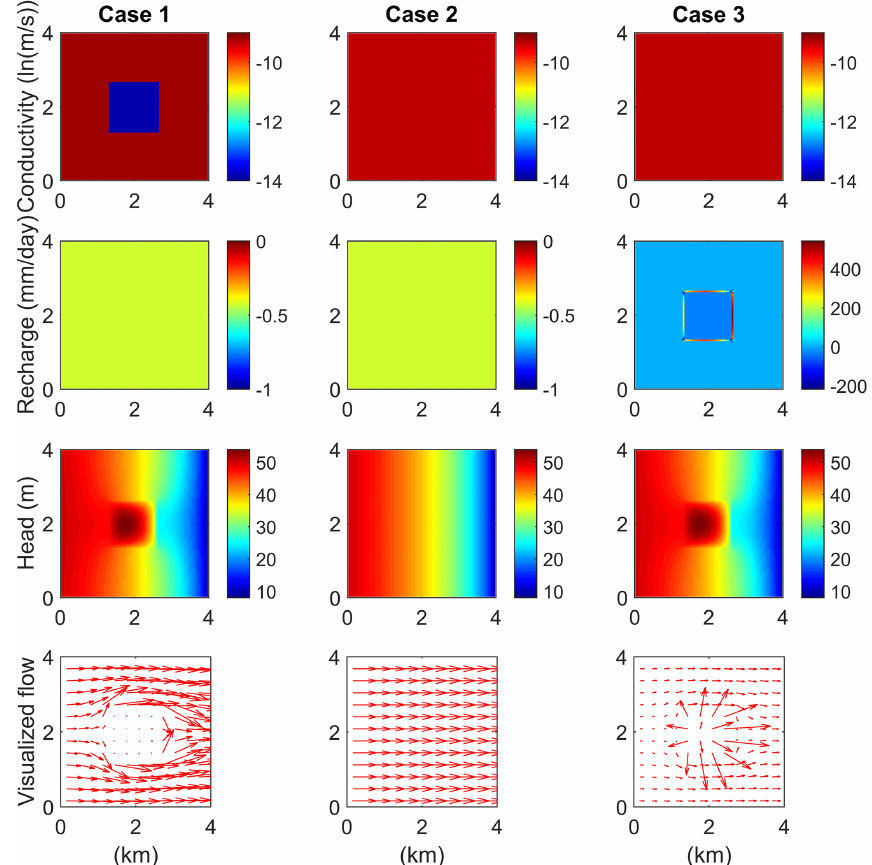
Figure 1. Illustrative example of replacing a heterogeneous conductivity field (left column panels) with a homogeneous conductivity and an effective recharge (right column panels). Please note the different scale on the third recharge